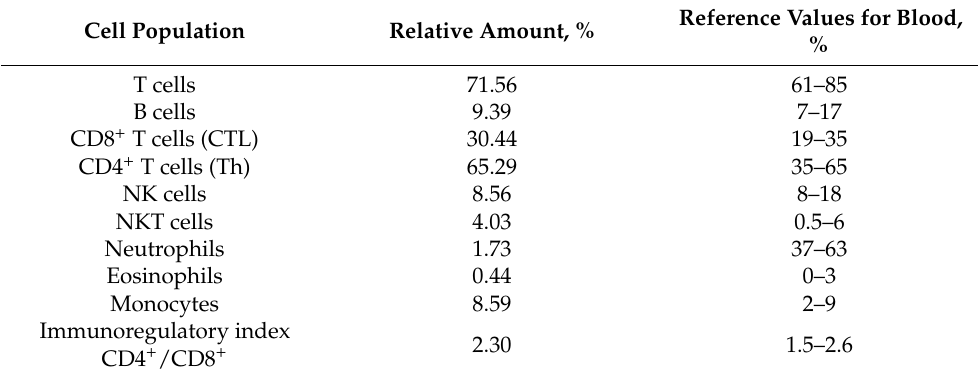
Table 1. Characteristics of PBMC isolated from the buffy coats of healthy donors.